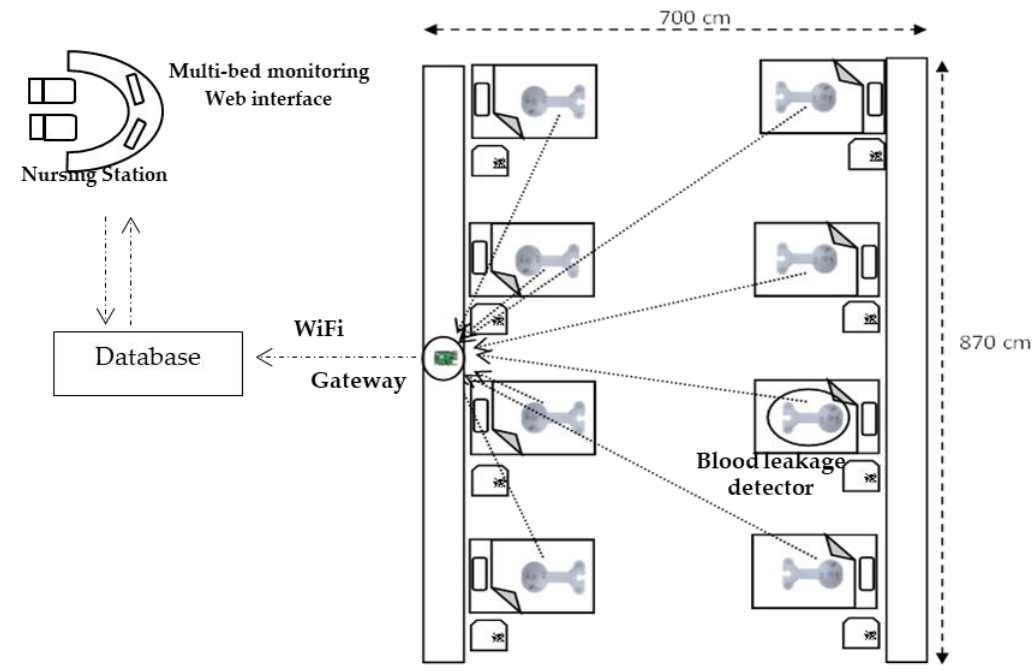
Figure 5. A diagram of the IoMT multi-bed monitoring system for leakage. The system could mon- itor needle dislodgement or blood leakage in real-time in multiple beds